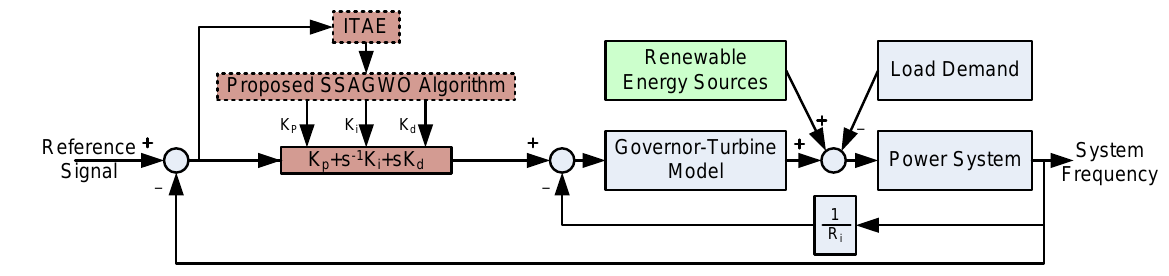
Figure 6. Close loop control system tuning.